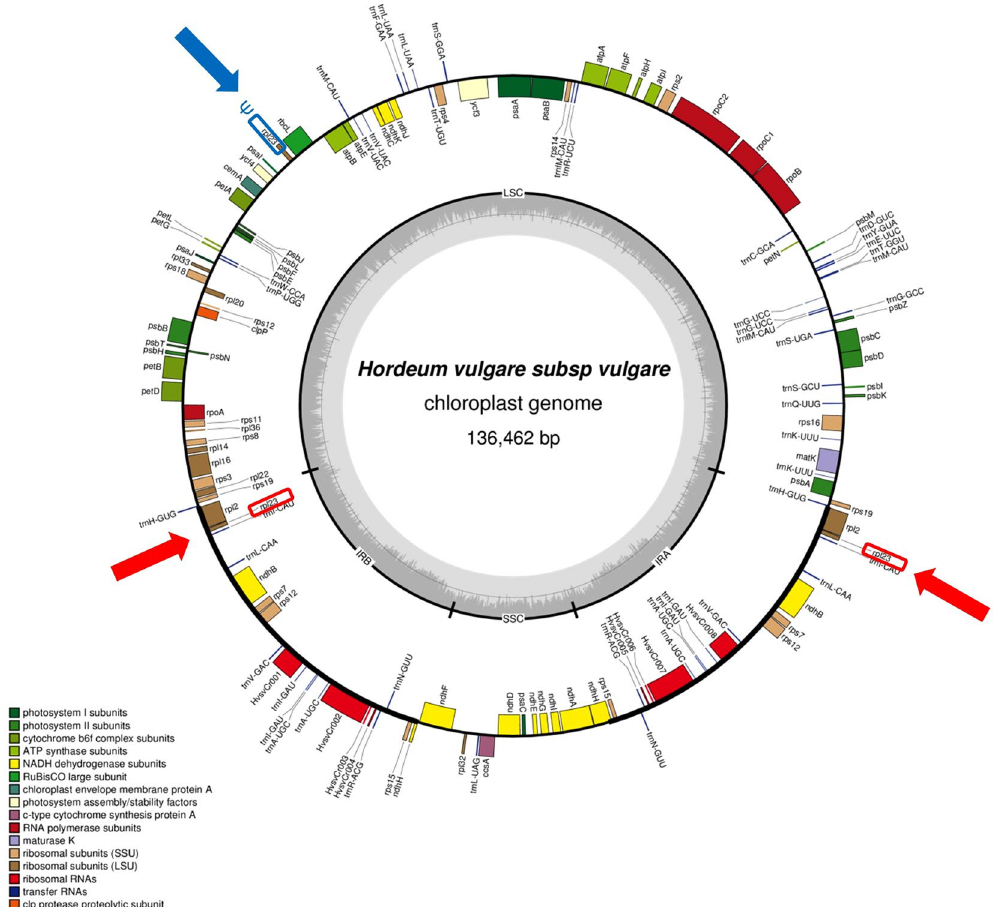
Figure 1. The chloroplast genome of barley. The rpl23 gene copies located in the inverted repeats (IRs) are highlighted in red and pointed by red arrows. The rpl23 pseudogene ( Ψ ) located in the large single copy region (LSC) is highlighted in blue and pointed by a blue